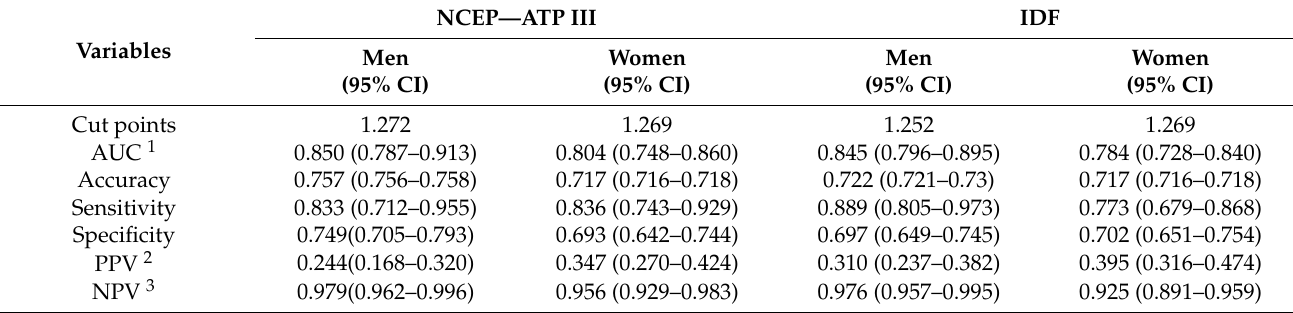
Table 1. Cut points and diagnostic performance measures for the conicity index according to the MetS criteria.